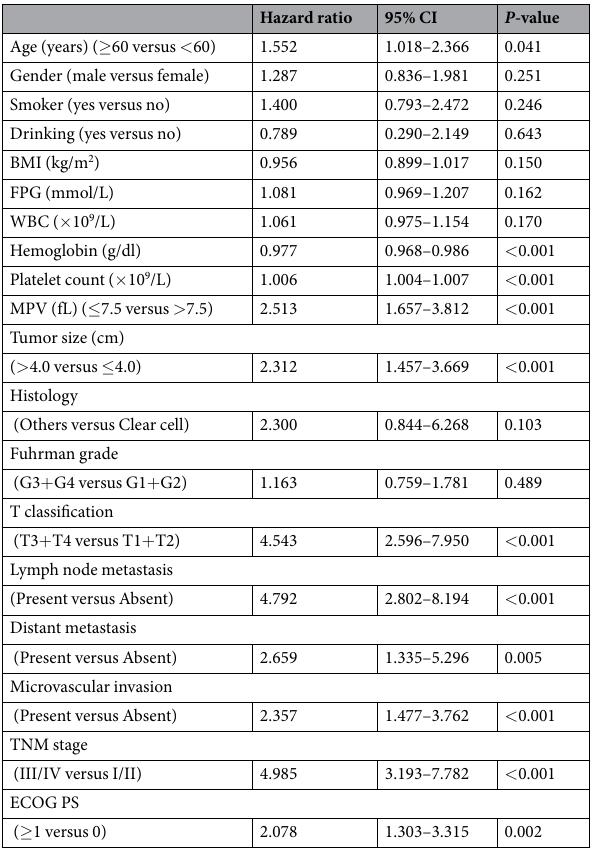
Table 3. Univariate analysis of overall survival in patients with renal cell carcinoma. Abbreviations: see to Table 1 and Table 2.